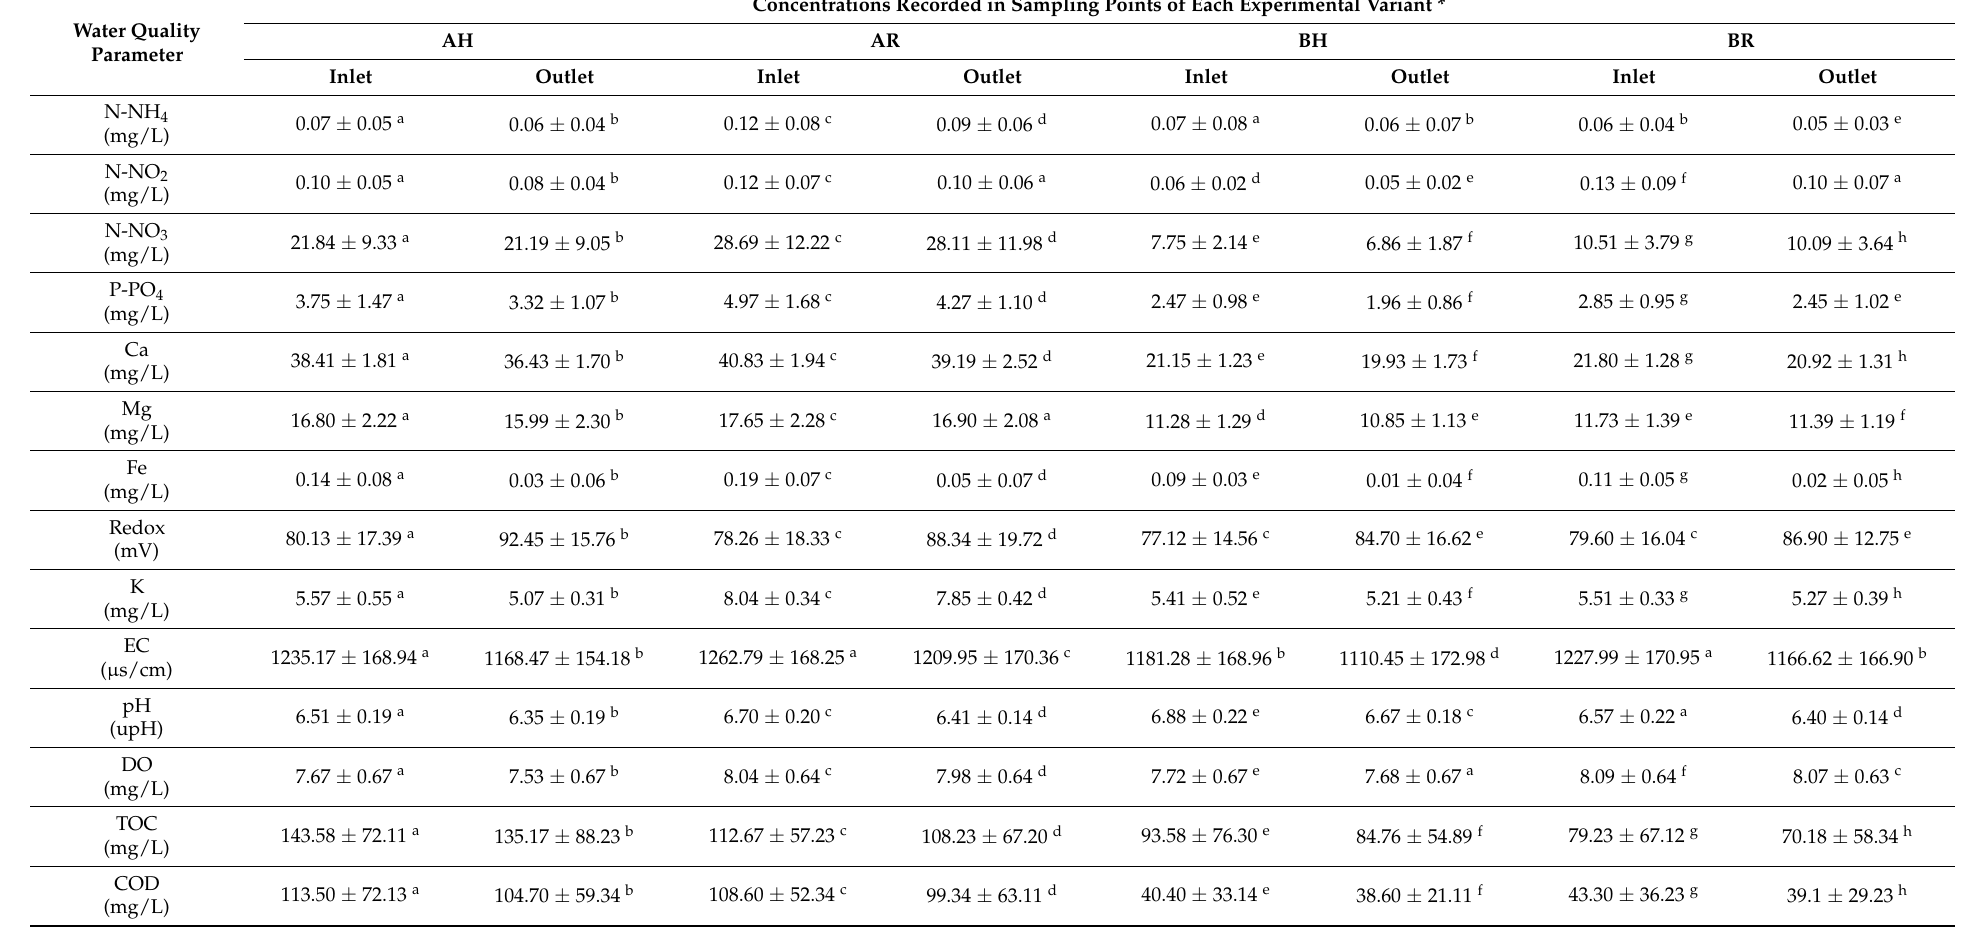
Table 5. The average concentration of main water quality parameters recorded at both inlet and outlet of aquaponics modules corresponding to each experimental